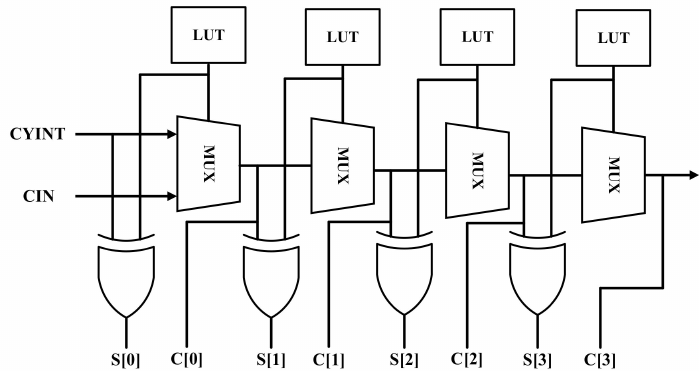
Figure 2. Simplified diagram of the structure of the CARRY4